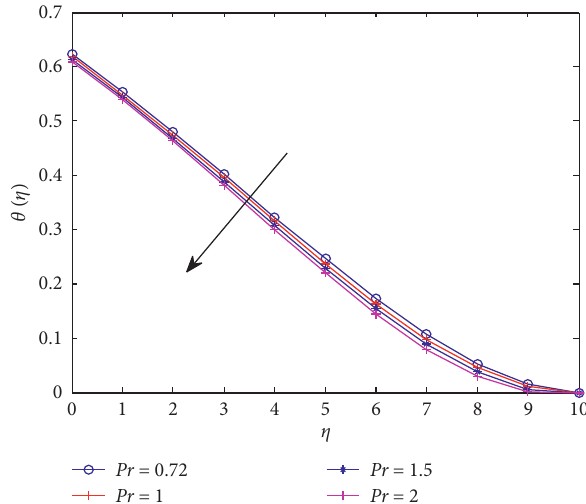
Figure 9: Temperature profiles for various values of the Prandtl number ( Pr ) when λ � 0.1, M � 0.1, Gr � 0.1, Ra � 0.1, and Bi � 0.1.